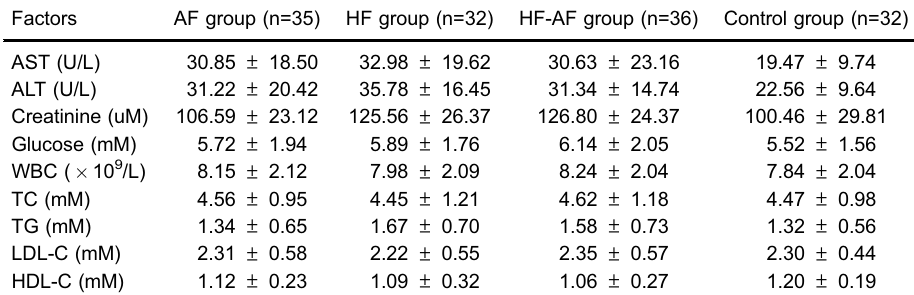
Table 2. Comparisons of biochemical indicators among the groups.